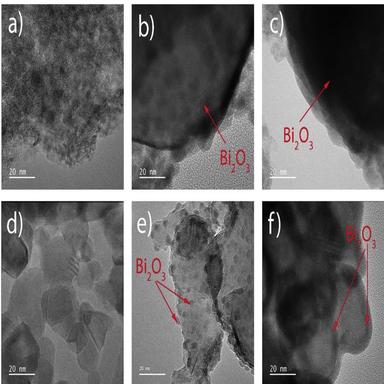
HRTEM images of uncoated and bismuth oxide-coated titania samples: a) sample PC500; b) sample PC500Bi30; c) PC500Bi60; d) sample P25; e) sample P25Bi60; f) sample P25Bi60.